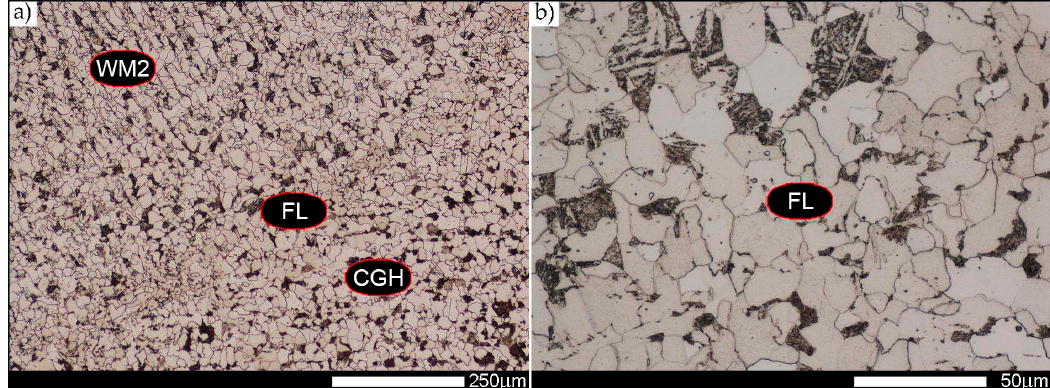
Figure 17. Welded joint microstructure of Hardox 450 steel in the normalised state—FL zone shown in Figure 2b. ( a ) 100×; ( b ) 500×. Structure of near-equilibrium grains of ferrite and lamellar and fine-lamellar pearlite. Tertiary cementite is also observed locally, often forming a continuous network around the ferrite grains. WM2—weld material zone 2, FL—fusion line, CGH(AZ)—coarse-grained zone. Light microscopy, etched with 3% HNO 3